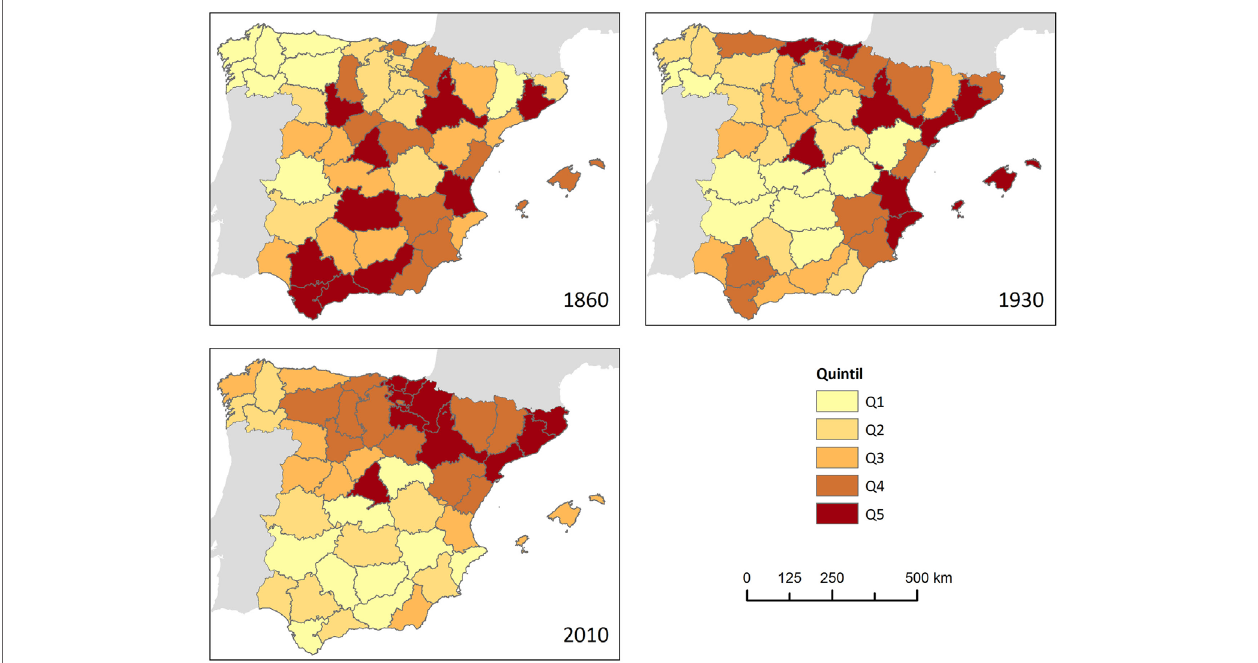
FigUre 1 | Evolution of quantiles of per capita GDP by Spanish province (NUTS3). The regions (NUTS) are grouped by quintiles. The darker the color representing the province, the richer it is. No permission is required for the use and reproduction of this data. Source: Tirado et al. (2016), p.